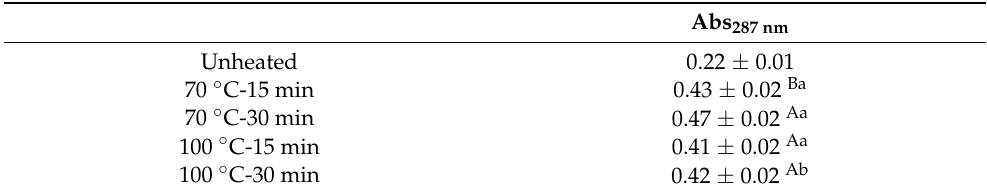
Figure 1. UV–VIS spectra ( A ), intrinsic tryptophan fluorescence ( B ), and CD spectra ( C ) of myosin after being heated at different cooking conditions. after being heated at different cooking conditions. Table 1. The effects of different heating treatments on the characteristic peaks of UV − VIS spec- troscopy (x ± s, n =